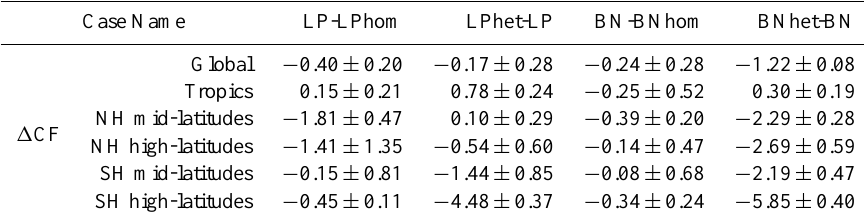
Fig. 9b. Same as Fig. 9a but for ice water path (IWP), cloud-top ice effective radius (ACTREI), and column cloud ice number concentration Figure 9b. Same as Figure 9a but for ice water path (IWP), cloud-top ice effective radius (CDNUMI). (ACTREI), and column cloud ice number concentration (CDNUMI). Table 3. Global, tropical (30 ◦ S–30 ◦ N), Northern Hemisphere (NH) and Southern Hemisphere (SH), mid-latitude (30–60 ◦ S and 30–60 ◦ N), and high-latitude (60–90 ◦ S and 60–90 ◦ N) annual mean changes ( 1 ) of net cloud forcing (CF, Wm − 2 ) between the combined and pure homogeneous nucleation simulations and between the pure heterogeneous and combined nucleation simulations for the LP05 and BN09 parameterizations. Standard deviations ( ± σ) are estimated from means of each of